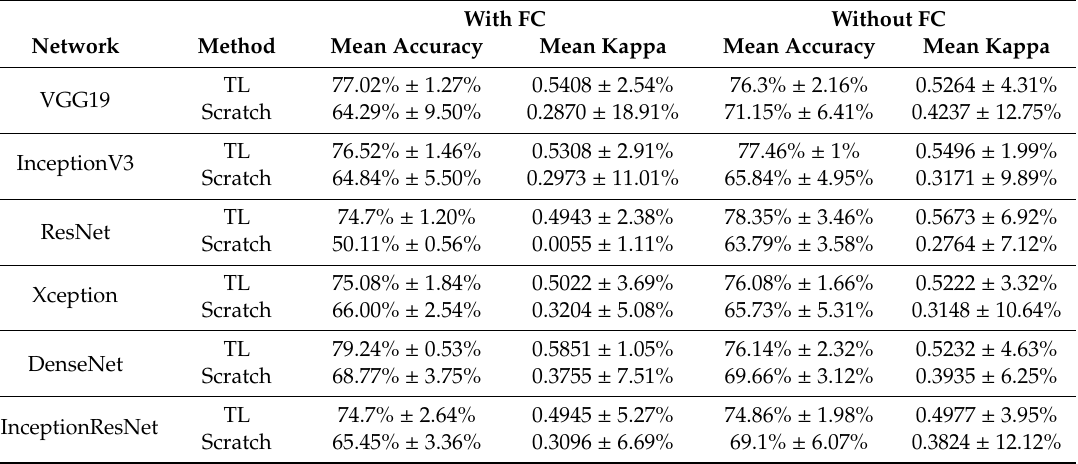
Table 8. Accuracy and Kappa scores of classifying forearm images with and without fully connected layers ( ± 95%